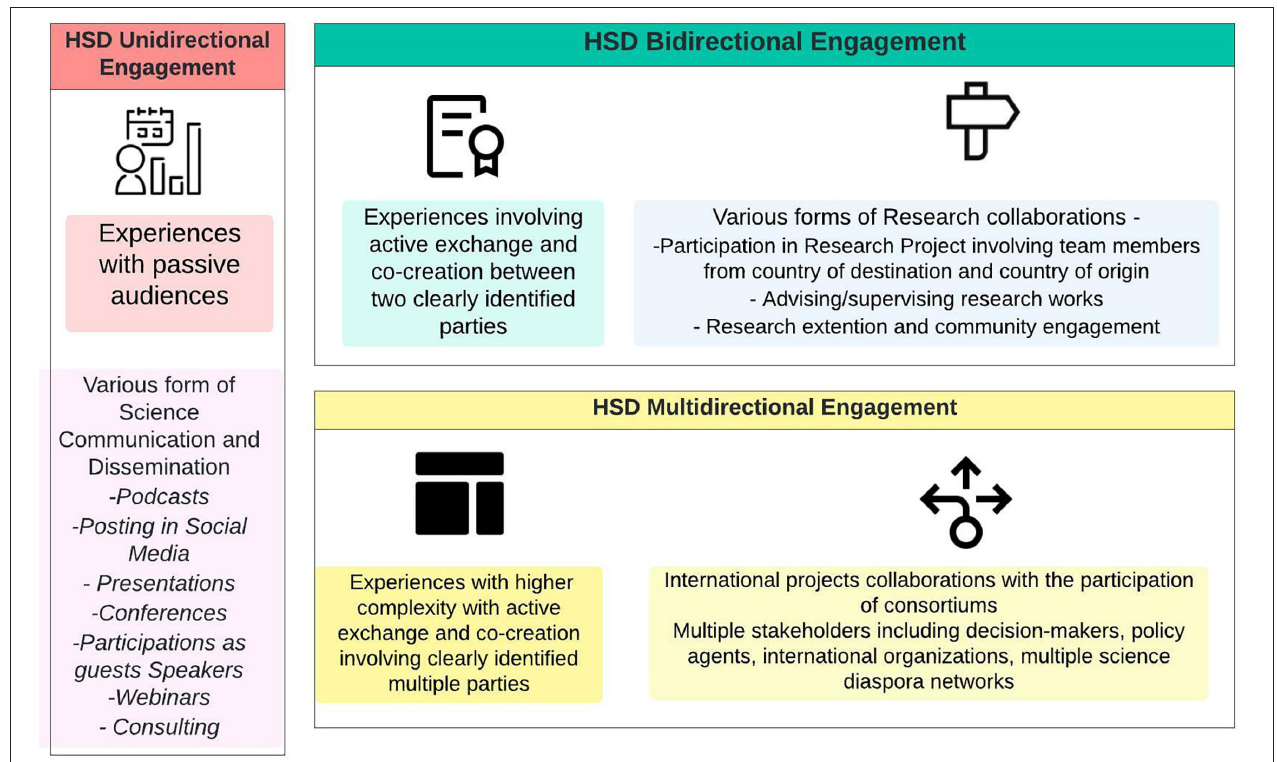
FIGURE 1 | HSD directional